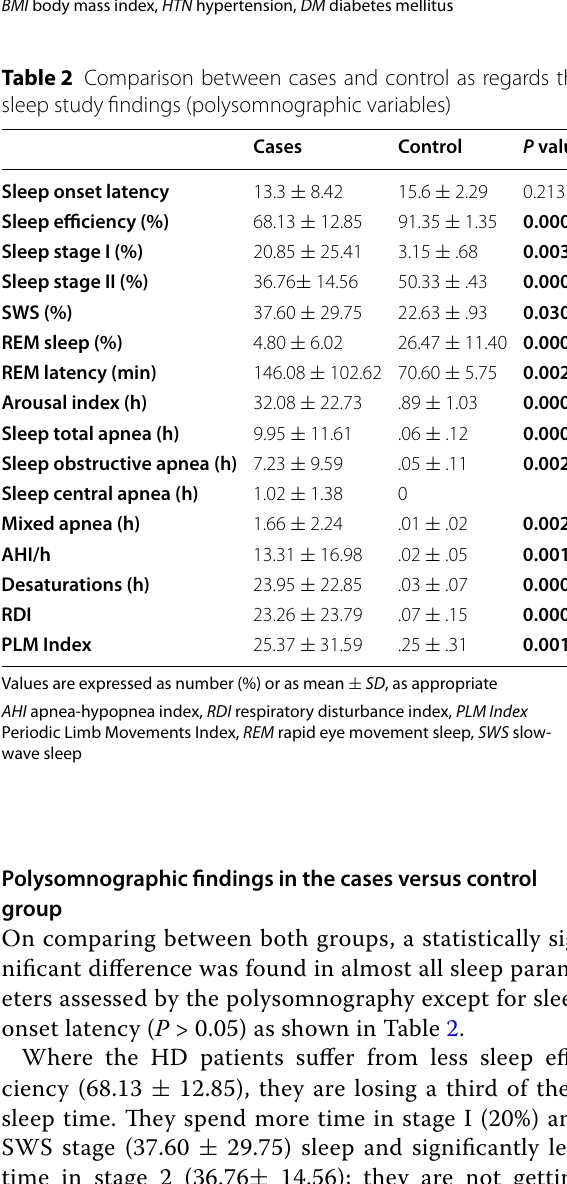
BMI body mass index, HTN hypertension, DM diabetes mellitus Table 2 Comparison between cases and control as regards the sleep study findings (polysomnographic variables)